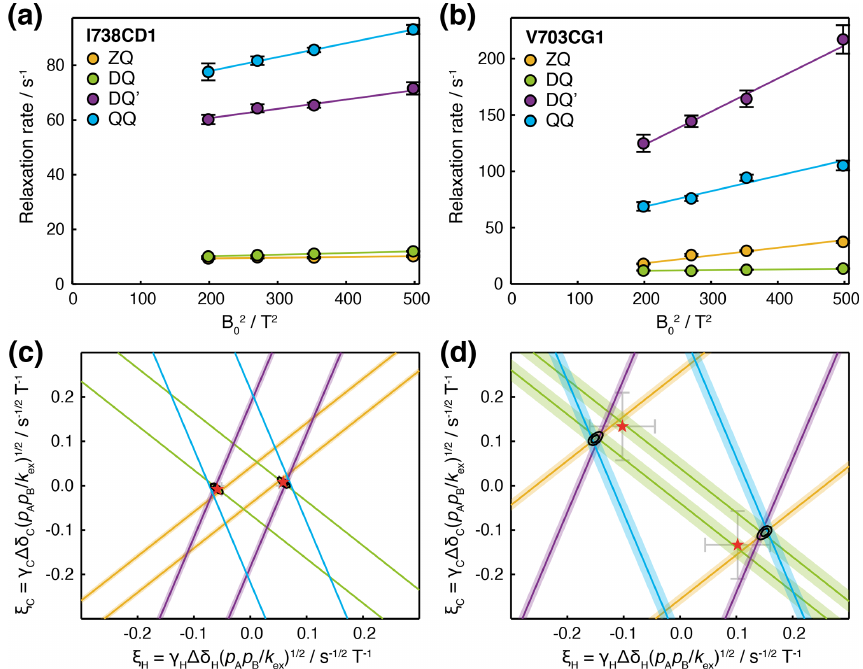
Figure 5. Analysis of magnetic field dependence of HE relaxation rates. (a, b) Linear regression analysis of methyl ZQ, DQ, DQ (cid:48) and QQ HE relaxation rates as a function of B 2 , for (a) I738CD1 and (b) V703CG1 resonances. Error bars indicate the standard error determined 0 from curve fitting of relaxation measurements. (c, d) Visualisation of constraints on ( ξ H ,ξ C ) parameter space arising from HE measurements. Straight lines indicate values of ξ H and ξ C consistent with HE measurements in the upper panels, calculated according to Table 1 assuming fast exchange and subtracting measured CSA contributions. Shading indicates the standard error propagated from linear regression analysis and CSA measurements. Black contours indicate 68% and 95% confidence intervals in ξ H and ξ C , based on all four HE measurements and assuming two-state fast exchange. Red symbols indicate ξ H and ξ C parameters derived from global fitting of HE and CPMG data (Fig.